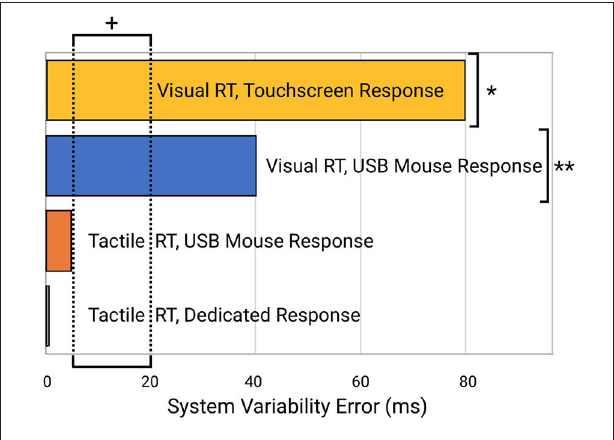
FIGURE 6 | Comparison of system errors potentially introduced from the four different testing modalities. Note the indicated normative range of reaction time variability for human subjects (5–20 ms; indicated by “ + ”) is well below the errors introduced by the visual reaction time testing modalities (e.g., “*” for systems that use a visual stimulus and touchscreen device such as an iPad and “**” for systems that provide a visual stimulus and mouse or keyboard response with a desktop computer or